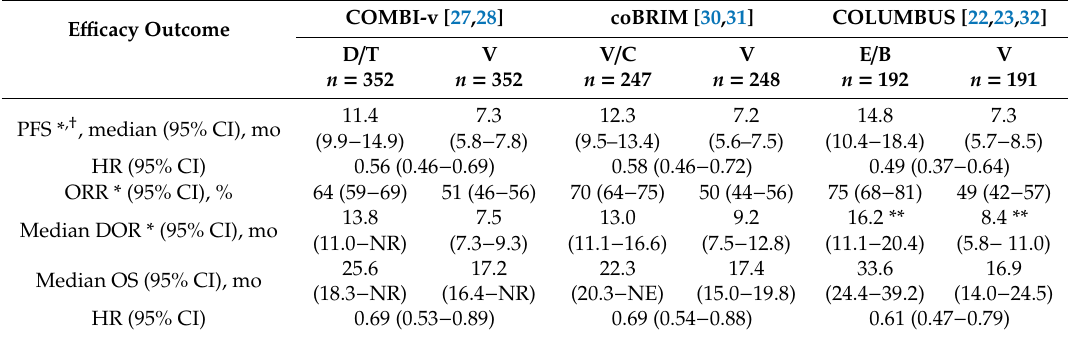
Table 2. E ffi cacy outcomes in the COMBI-v, coBRIM, and COLUMBUS trials. E ffi cacy Outcome